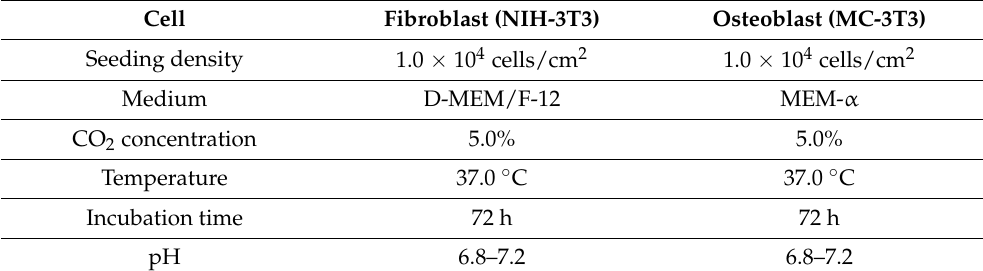
Table 2. Cell culturing